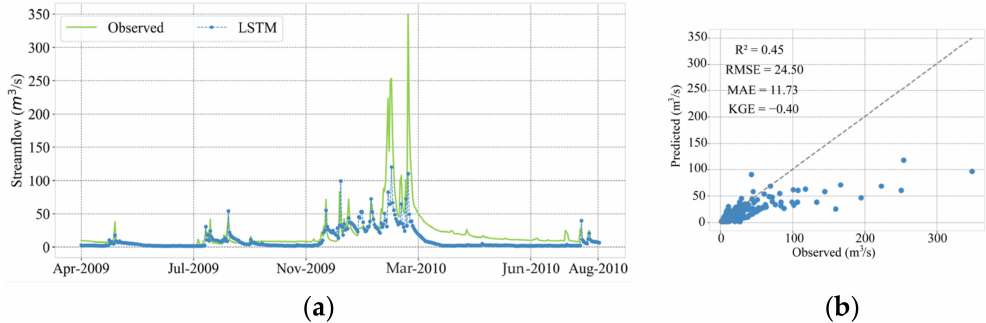
Figure 6. The hydrograph of observed and predicted daily streamflow of LSTM scenario during the testing ( a ) using approach 1 at TS = 30 along with the corresponding scatter plot ( b ).